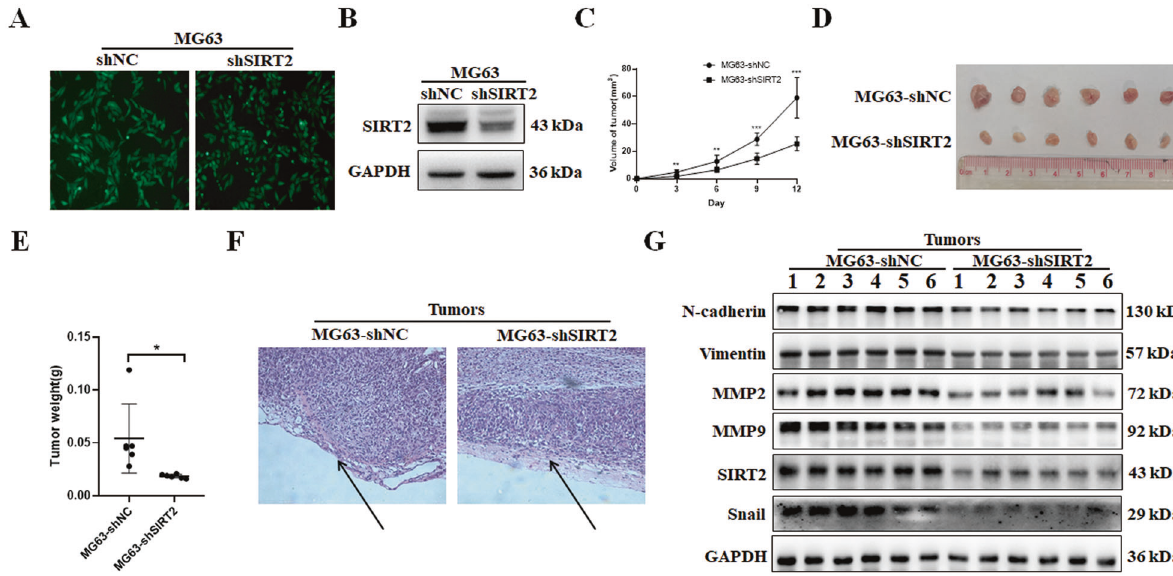
Fig. 5 SIRT2 knockdown inhibited the tumorigenic ability of osteosarcoma cells. A The ef fi ciency of SIRT2 shRNA lentivirus infection in MG63 cells was observed under a fl uorescence microscope. B Western blot was used to detect SIRT2 expression after SIRT2 shRNA infection of MG63 cells. C The tumor growth curve of nude mice subcutaneously injected with MG63-shSIRT2 and control cells. D The tumors of the nude mice in the two groups were isolated and photographed. E The tumors in the nude mice were weighed and compared. F H&E staining